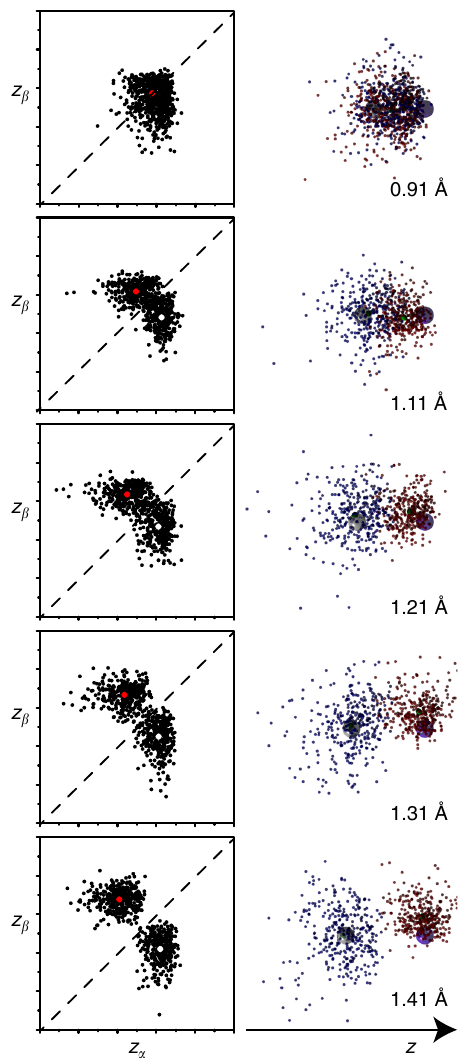
Fig. 5 The homolytic bond cleavage of hydrogen fl uoride to yield fl uorine and hydrogen atoms. For bond lengths 1.11 Å and longer, the wavefunction is two-humped, necessitating two Voronoi points (red and white). Projection of one sub-tile yields the structures plotted on the